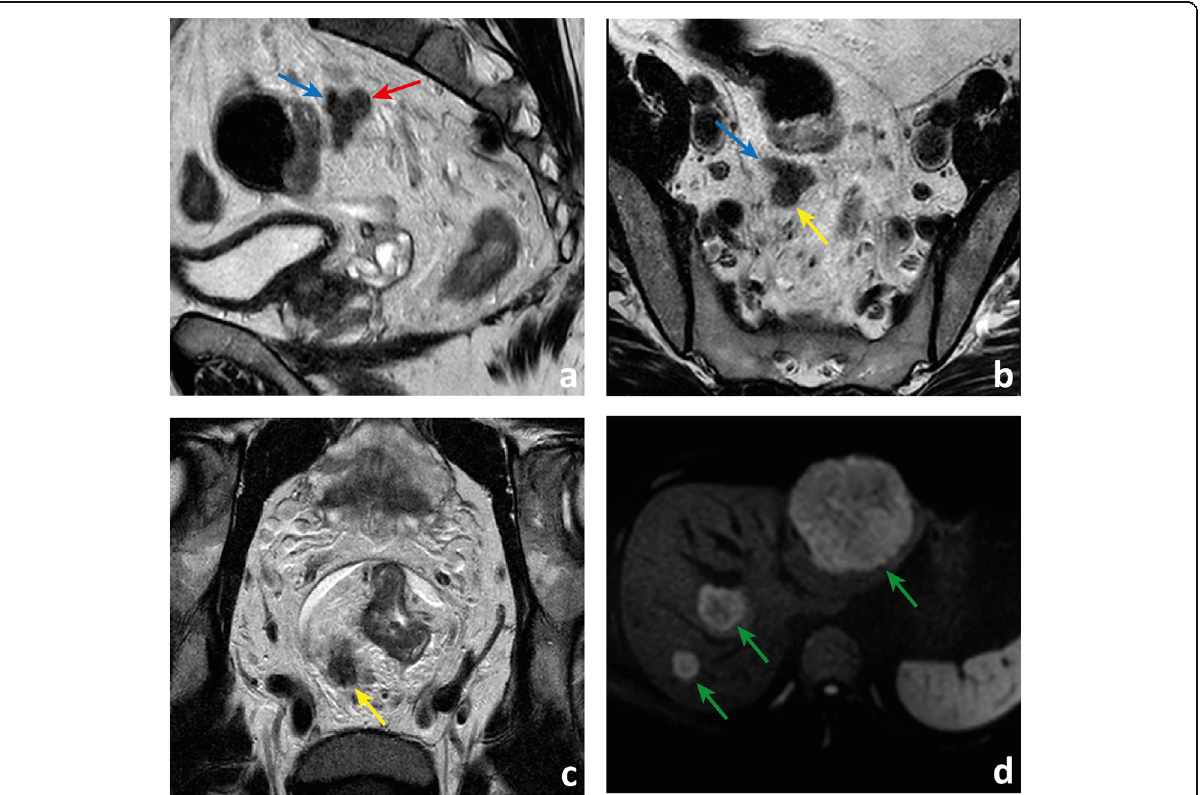
Fig. 17 A patient with an mrT3d MRF+ high rectal cancer also presents with a very irregular hypointense lesion in the high mesorectum (red arrow in a ) that appears to both interrupt the course of a vein suggesting mrENTD (blue arrow in a ) and to grow within it suggesting discontinuous mrEMVI (blue arrow in b ). It is also in continuity with a round, irregular and heterogeneous structure appearing to be a positive lymph node with extracapsular extension (yellow arrows in b and c ). The patient presented with synchronous metastatic liver disease, visible on b900 DWI (green arrows in d